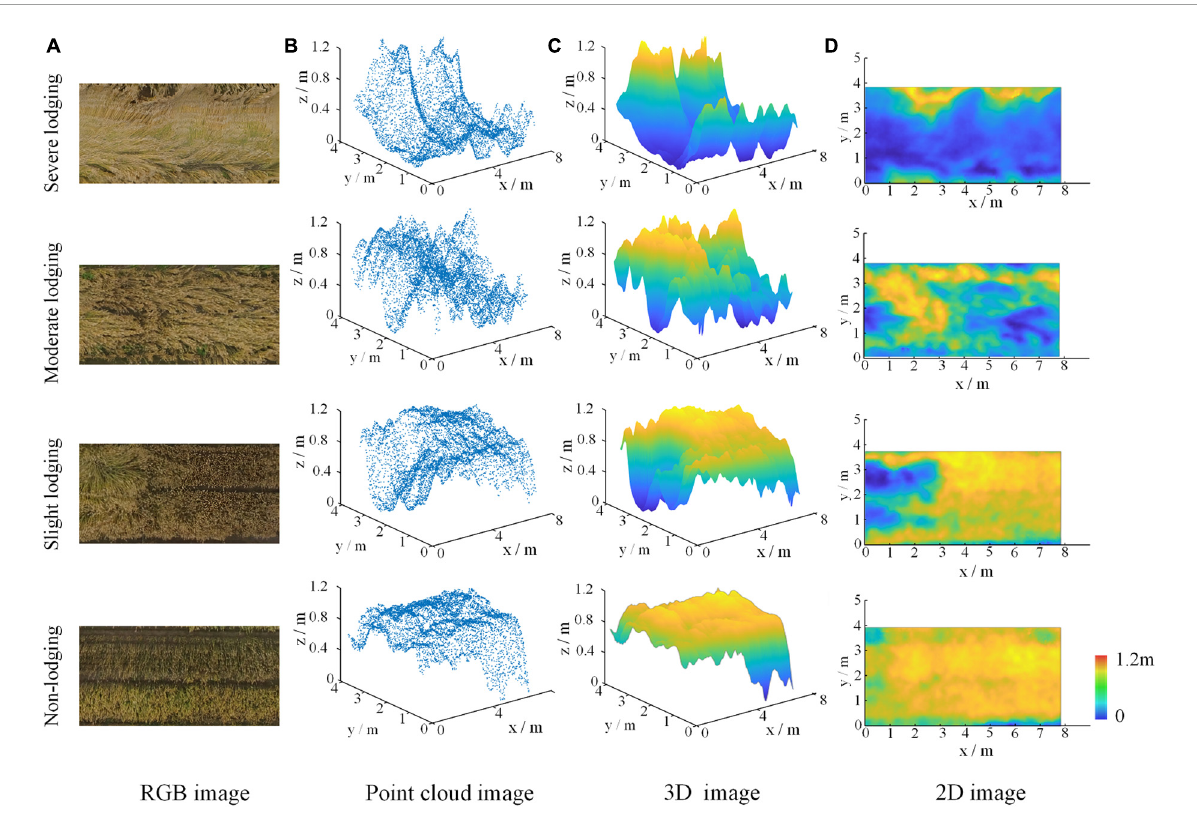
FIGURE6 The result of point cloud dimensionality reduction of wheat field at maturity stage. (A) RGB image, (B) point cloud image, (C) 3D image, and (D) 2D image.